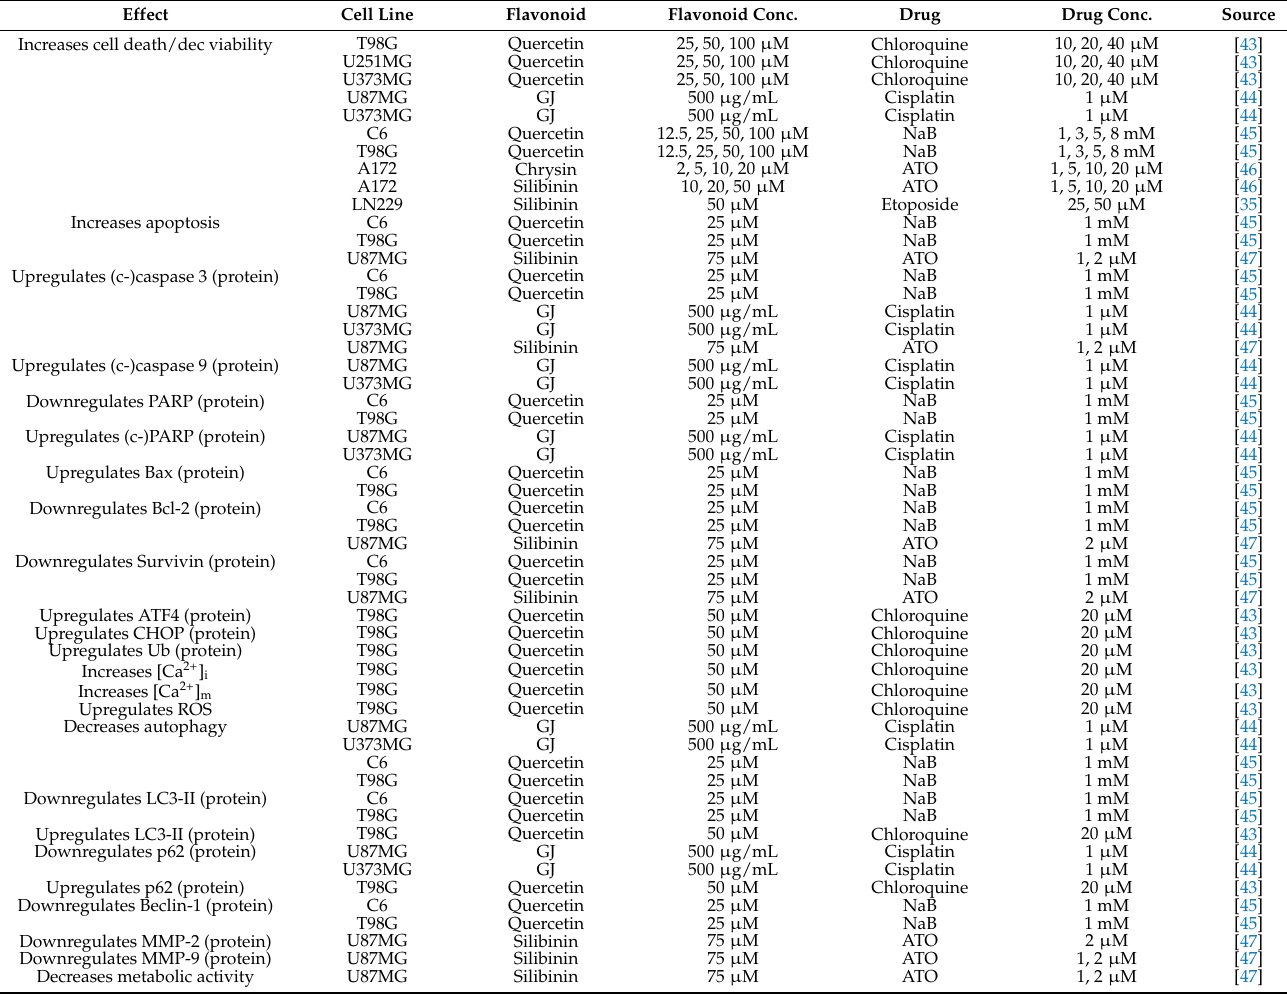
Table 4. Synergistic anti-GBM effects of quercetin–chloroquine, quercetin–NaB, GJ–cisplatin, silibinin–etoposide, silibinin– ATO, and chrysin–ATO combinations, as demonstrated in